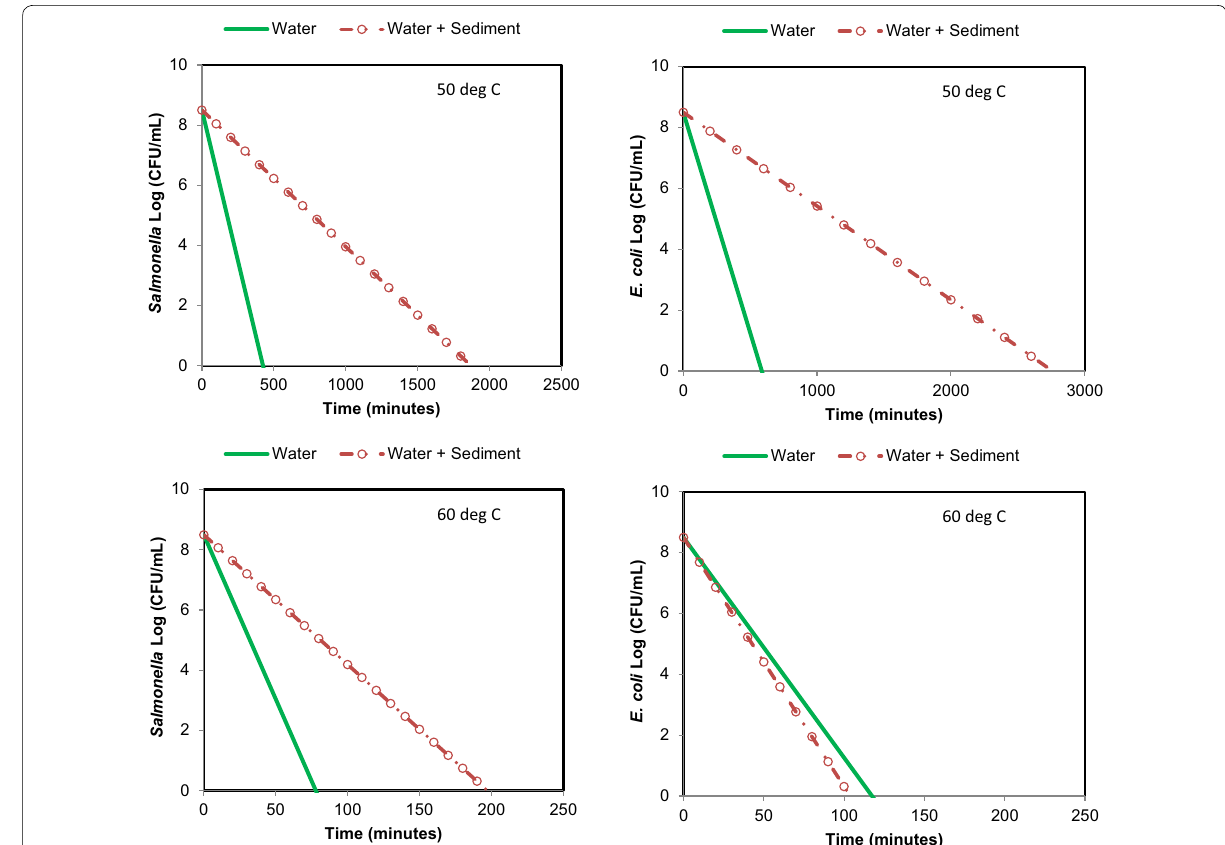
Fig. 8 Decay curve of E. coli O157:H7 and Salmonella at 50 and 60 °C under free floating and particle attached conditions (curves shown are the average of curve for Run 1 and curve for Run 2; equations are shown in Table